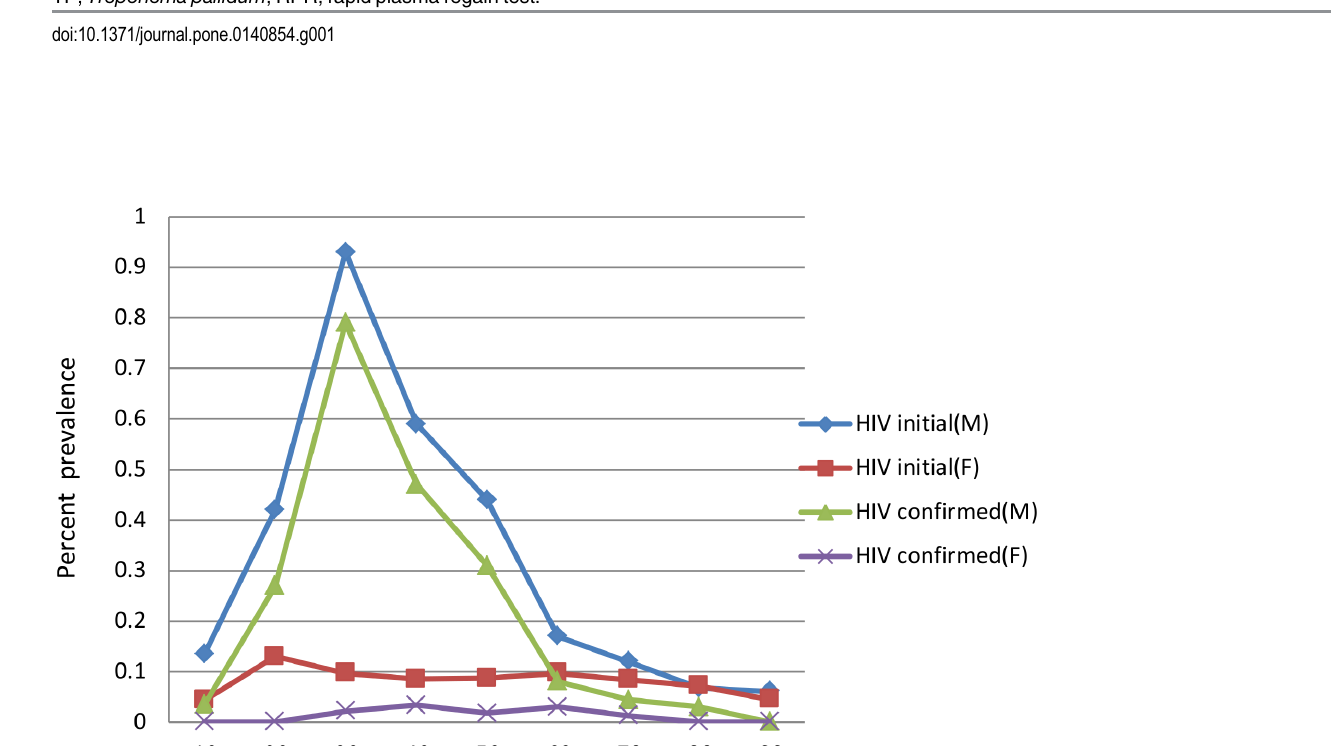
PLOS ONE | DOI:10.1371/journal.pone.0140854 October 26,